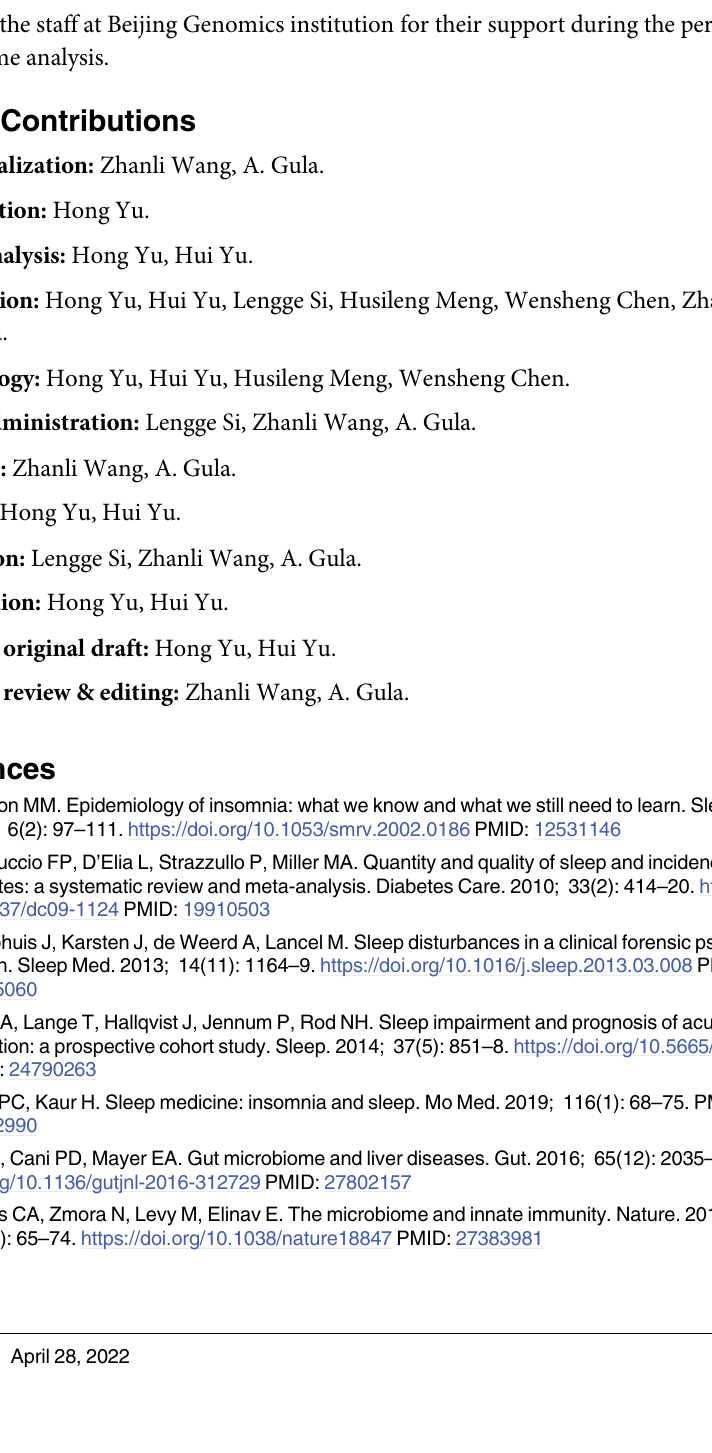
differential metabolites between the control group and the treatment group. (E) KEGG enrich- ment analysis of differential metabolites between the control group and the treatment group. (TIF) S7 Fig. Influence of the butyrate on the levels of cAMP in PCPA-induced insomnia rats. (TIF) S1 Raw image.